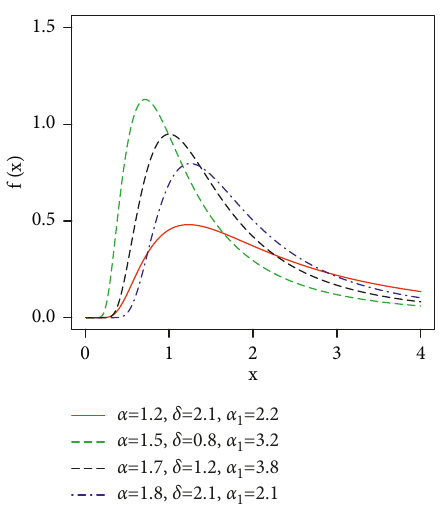
Figure 5: Some possible PDF plots of the APTE-IW